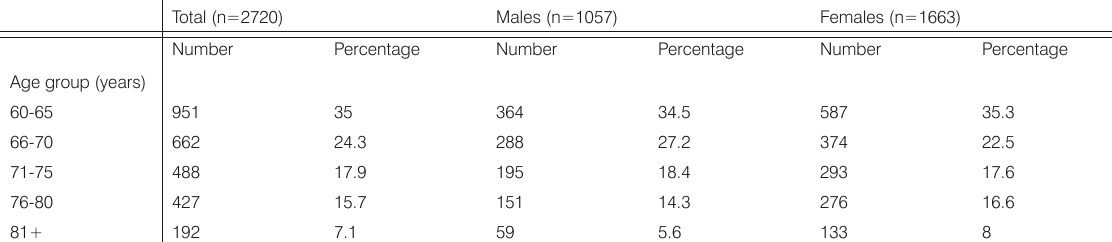
Table 1. Distribution of the participants by age and